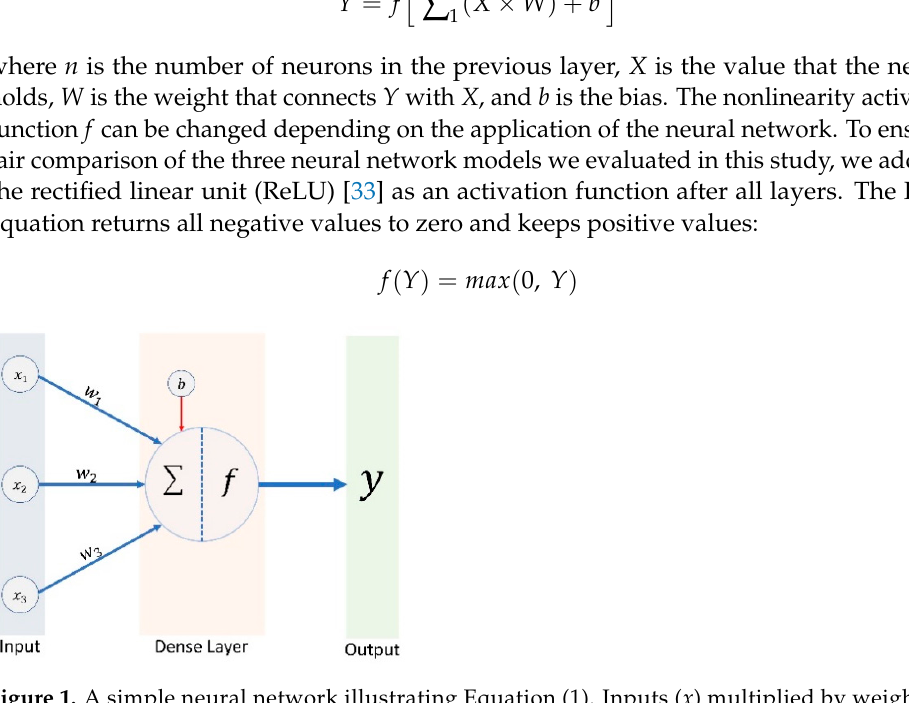
Activation function after the final layer